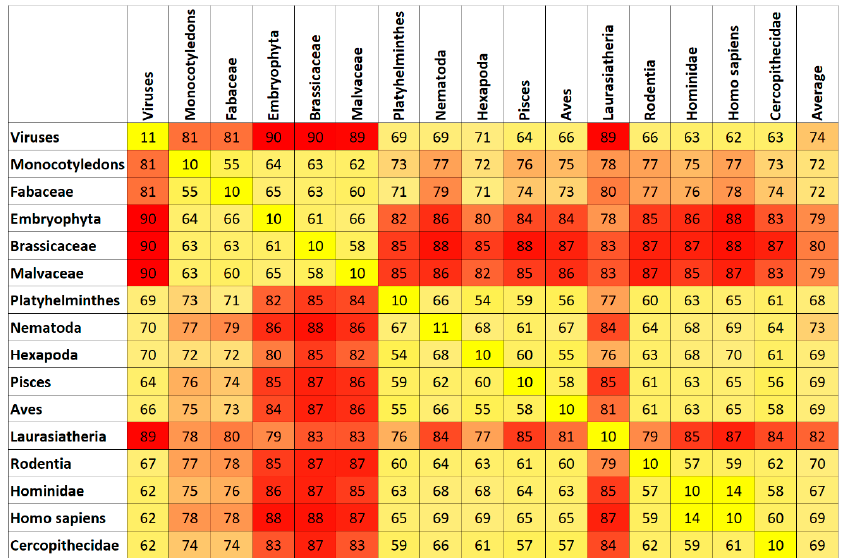
Figure 8. Average accuracy for 100-fold MCCV using a random forest classifier and a split of 80% training and 20% testing employing only secondary-structure-based features. Yellow shades indicate lower accuracy, while red shades show higher average classification accuracy.